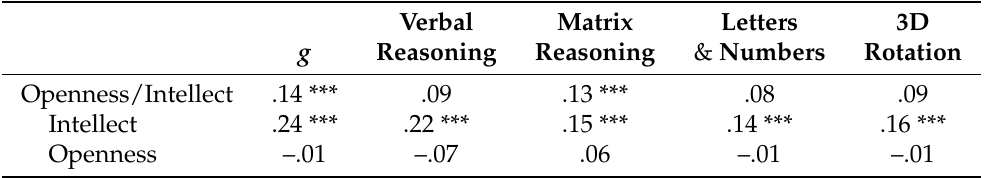
Table 4. Correlations between measures of cognitive ability and the Openness/Intellect domain and aspects in current